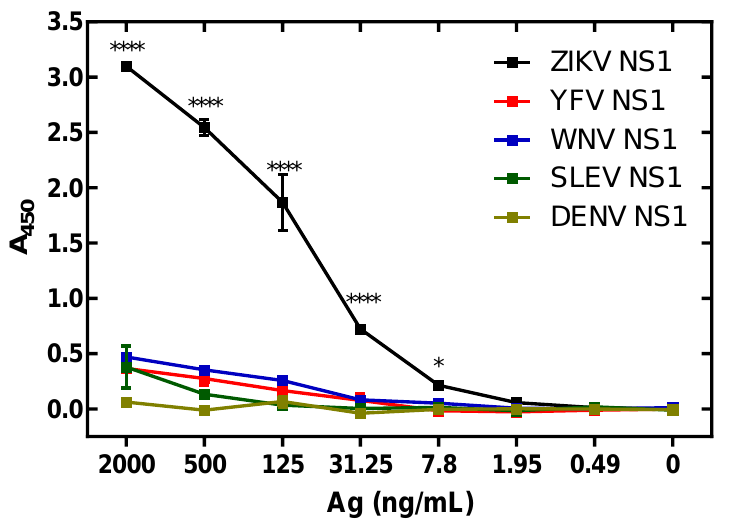
Figure 8. The ZIKV NS1 antigen-capture assay demonstrates low cross-reactivity to related viruses. Recombinant NS1 antigens were produced and assayed. A: Even at low levels of NS1 detection, the assay is specific to ZIKV NS1. Comparisons made using two-way ANOVA with a Holm–Sidak multiple comparisons test. Asterisks represent significant comparisons between ZIKV NS1 and all other NS1 proteins (**** p < 0.0001; * p < 0.05). Error bars represent the standard error of the mean.